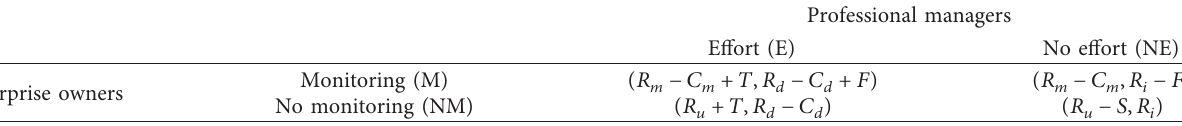
Table 2: Payoff matrix of enterprise owners and professional managers.